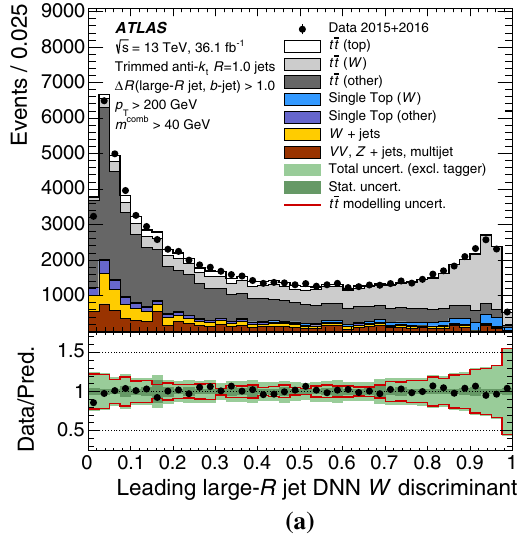
Fig. 12 A comparison of the observed data and predicted MC distri- butions of the anti- k t R = 1.0 trimmed jet DNN discriminant for W boson( a )andtopquark( b )taggingfortherespectiveeventselectionsin a sample enriched in lepton+jets t ¯ t events. Simulated distributions are normalised to data. The t ¯ t sample is divided into a set of subsamples